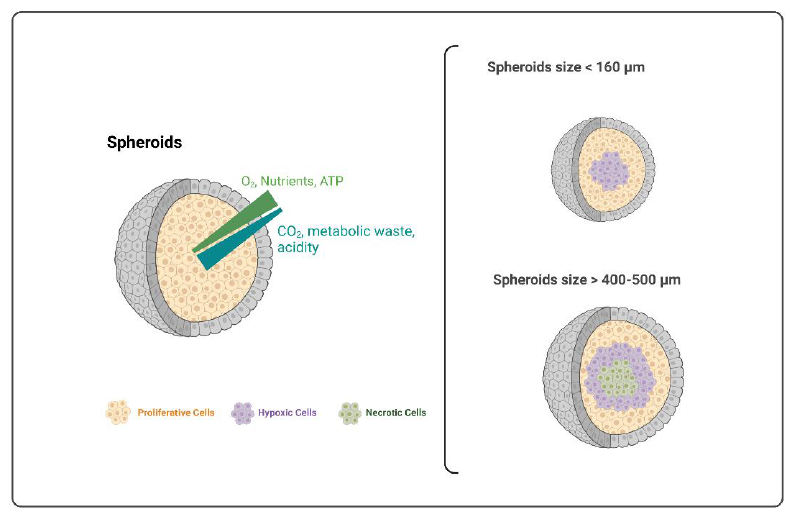
Figure 3. Representation of spheroid constitution and the core features according to their size.